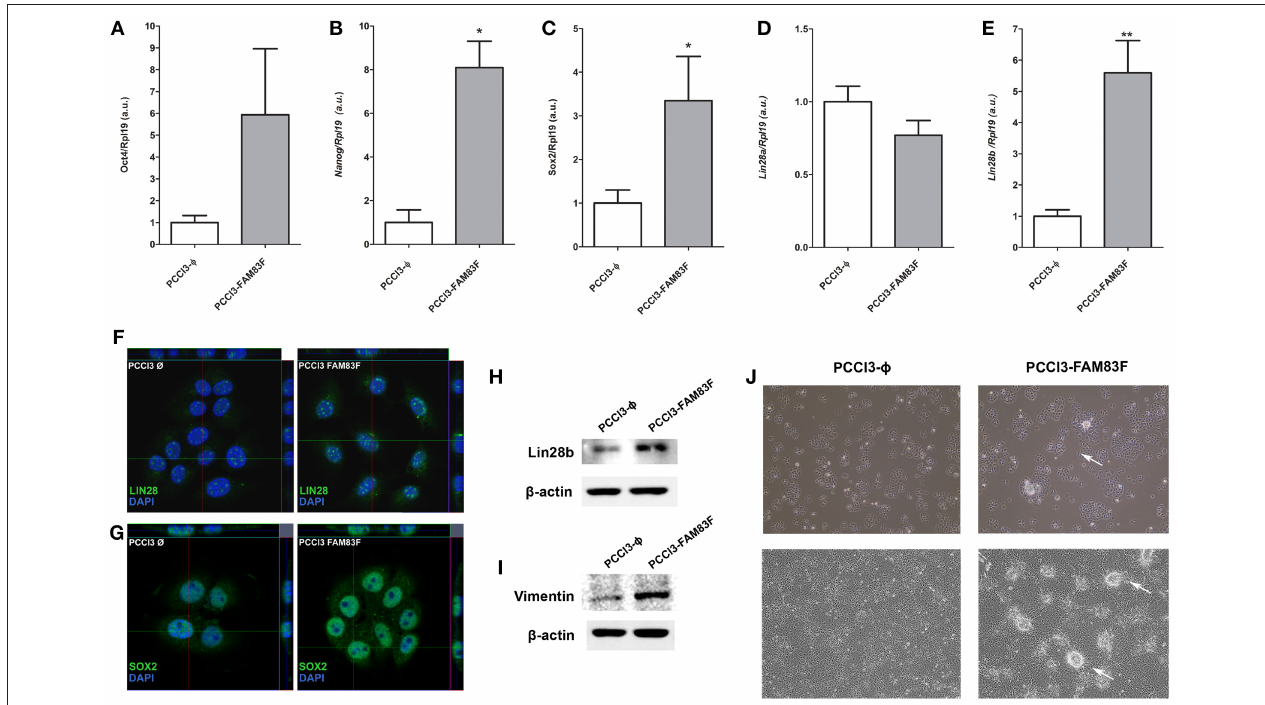
FIGURE 3 | FAM83F overexpression effects on stem cell markers expression of PCCL3 cell line. (A) Gene expression of Oct4 ; (B) Nanog ; (C) Sox2 ; (D) Lin28a ; and (E) Lin28b by qPCR in PCCL3-FAM83F cells. Data shown as mean ± SD of two independent experiments performed in triplicate normalized by PCCL3- φ . * P < 0.05; ** P < 0.01. (F,G) Protein expression of LIN28 and SOX2 analyzed by confocal microscopy in PCCL3-FAM83F cells using secondary antibody anti-rabbit Alexa Fluor ® 488 (green); (H) LIN28B protein levels and; (I) Vimentin protein levels in PCCL3-FAM83F compared to PCCL3- φ by Western-blotting. The same control β -actin was used from Figure 2H as membranes were probed with different antibodies. (J) Cell morphology of PCCL3-FAM83F and PCCL3- φ cells in culture at low and high confluency, showing the formation of spherical structures (indicated by the arrows) in PCCL3-FAM83F. 10 × magnification under EVOS ® XL Core Imaging